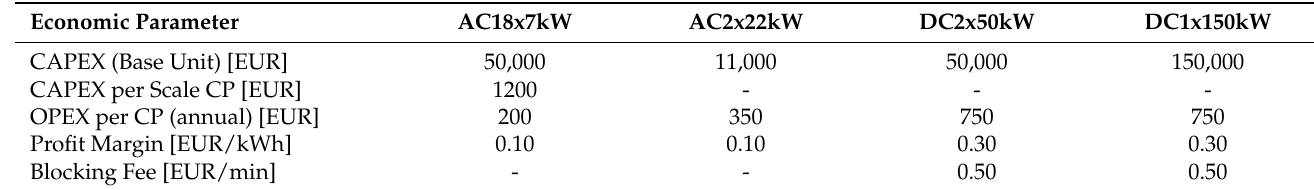
Table 3. Economic Parameters of the Investigated Charging